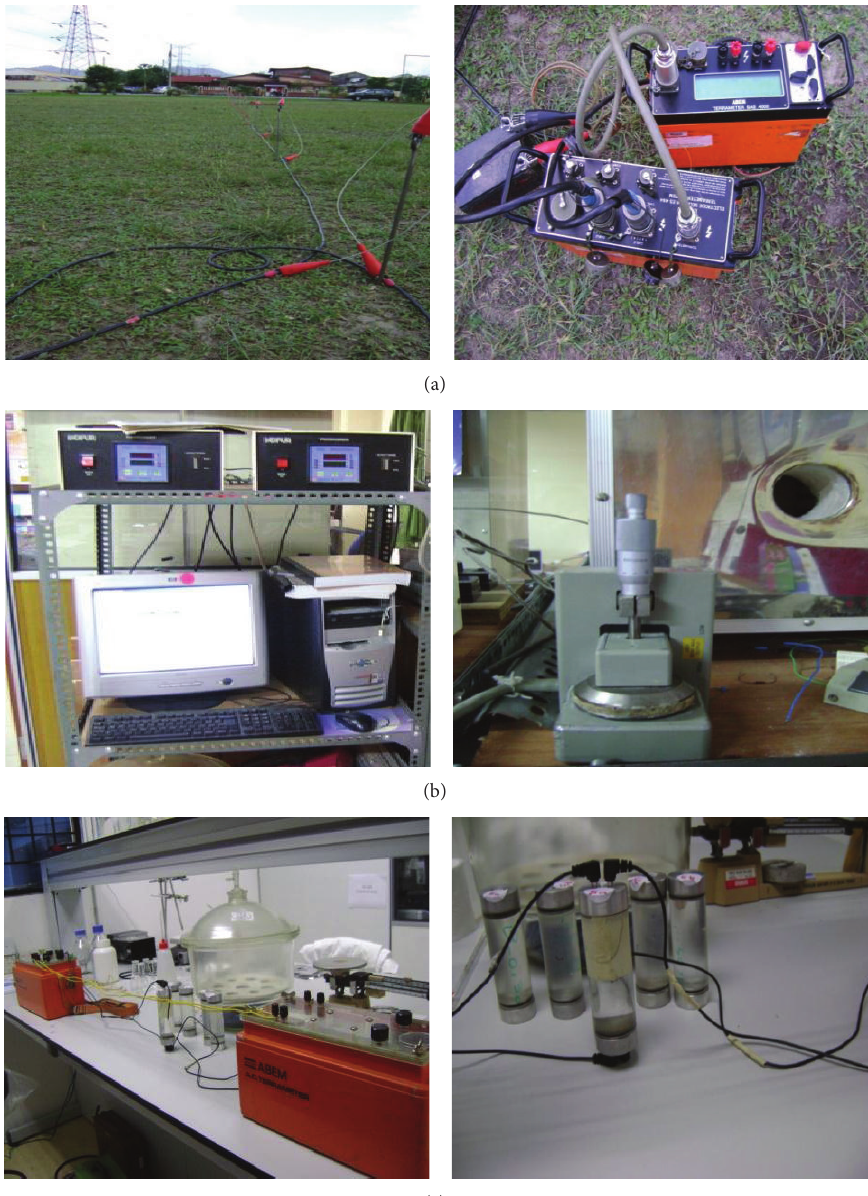
Figure 4: Field and laboratory measurement of electrical resistivity. (a) ABEM Terrameter (Ohm/ Ω ) resistivity meter in the field (Model- 2115), (b) a precision inductance, conductance, and resistance (LCR) meter for conductance and resistance of rock (LCR), and (c) ABEM Terrameter (Ohm/ Ω ) resistivity meter of soil and water in